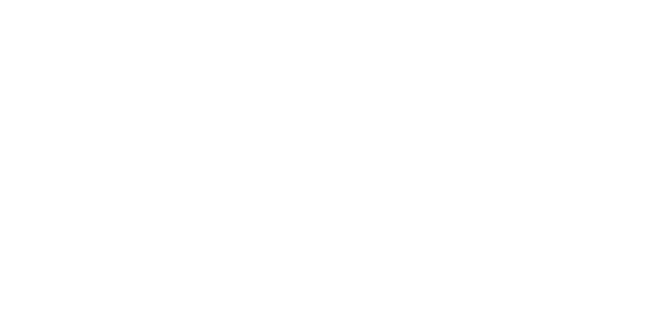
Table 3 HPTLC peak table of methanolic extract of F. parviflora Lam. (at 254 nm, track